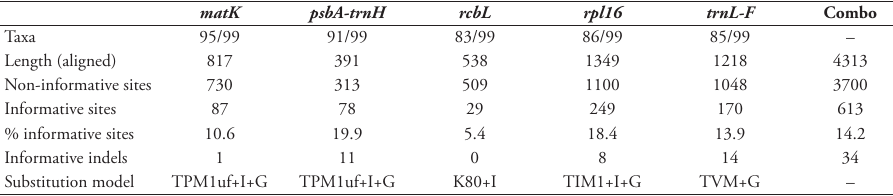
Table 1. Data of the aligned sequences used in the phylogenetic analysis.